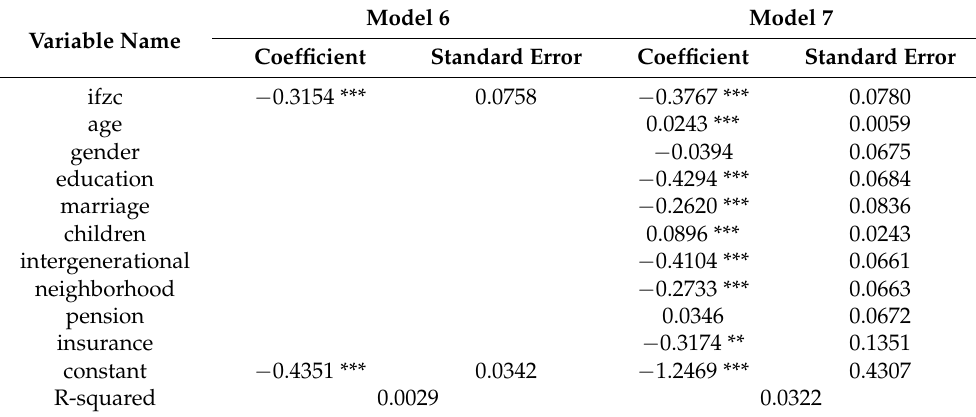
Table 5. Empirical estimates of the relative multidimensional poverty of the rural elderly in rural land